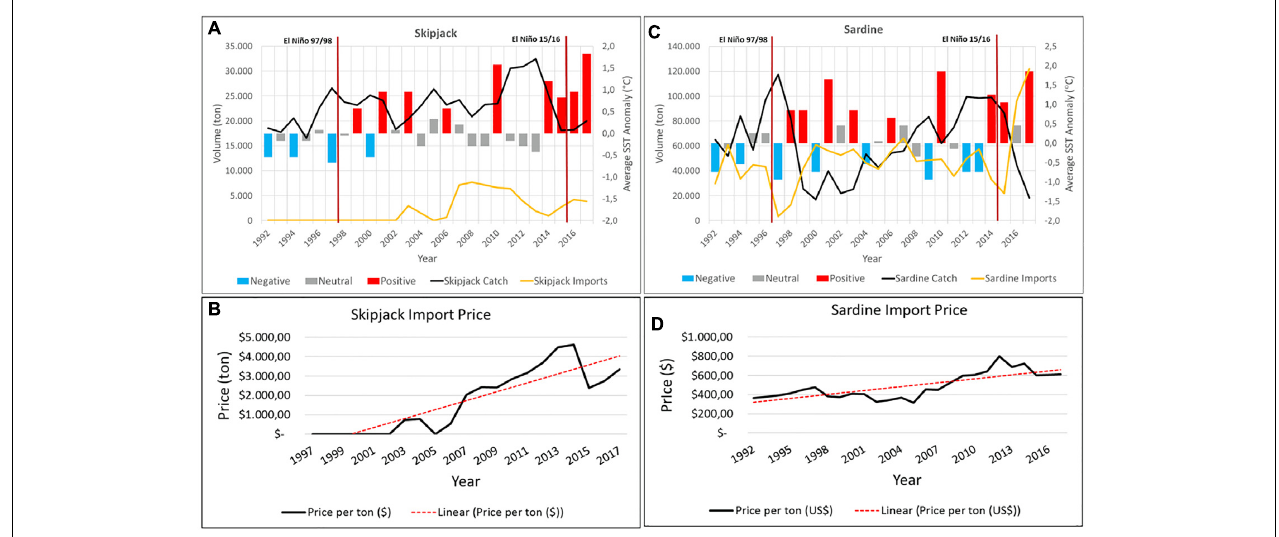
FIGURE 2 | Skipjack (A) and sardine catches (C) from 1992 to 2017 along the south east and south Brazilian coasts associated to SST average annual anomalies from virtual stations over the 50 m and 1000 isobaths. Skipjack (B) and sardine (D) import volumes and prices over the study